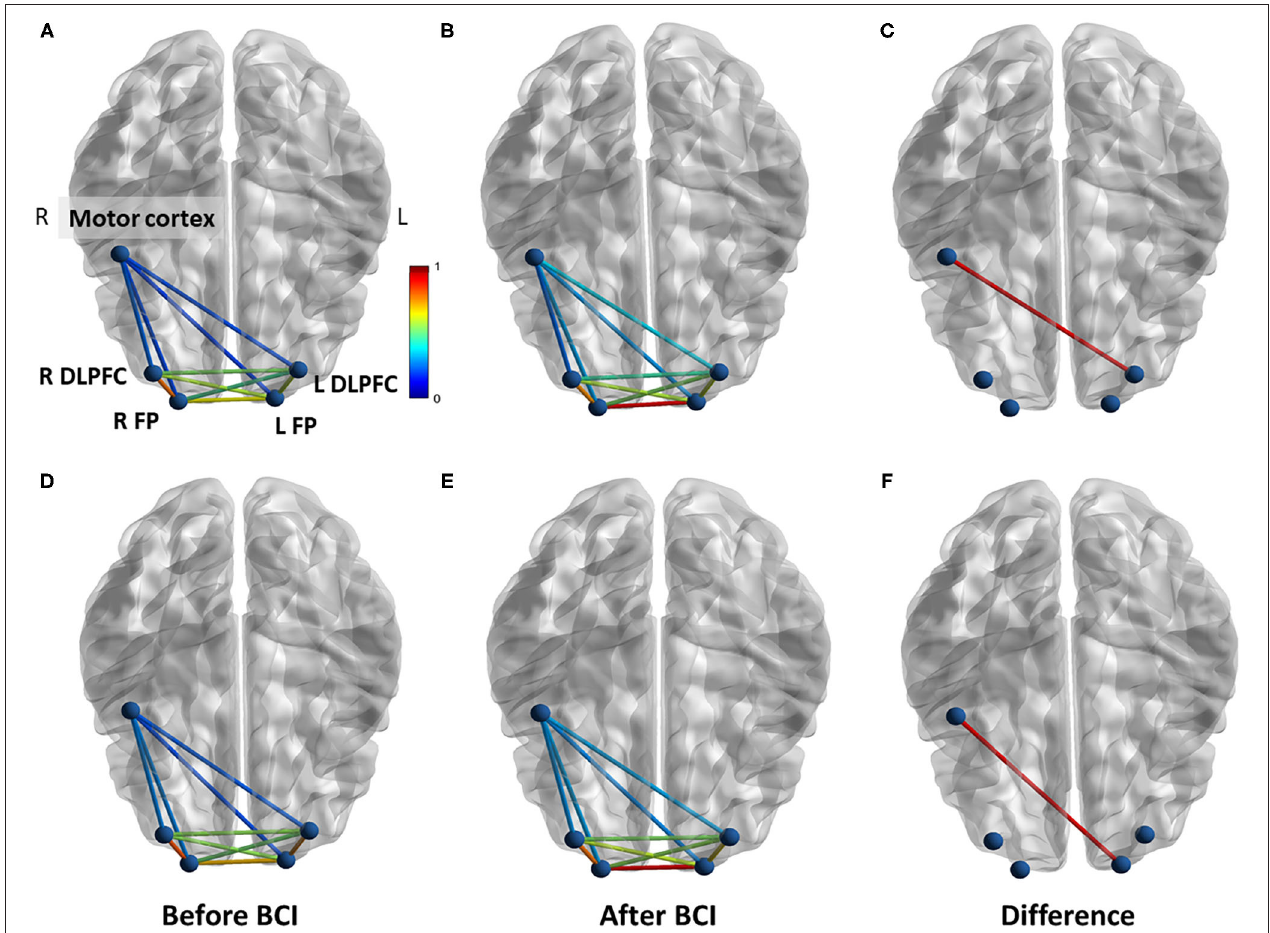
FIGURE 8 | Functional connectivity change measured during force tracking task in BCI-only session. (A) Coherence between each ROI at baseline. (B) Coherence between each ROI after BCI training. (C) Coherence between right motor cortex and left DLPFC was significantly increased after BCI training. (D) PLV between each ROI at baseline. (E) PLV between each ROI after BCI training. (F) The PLV between right motor cortex and left FP was significantly increased after BCI training. L refers to left. R refers to right. DLPFC refers to dorsal lateral prefrontal cortex. FP refers to frontal polar